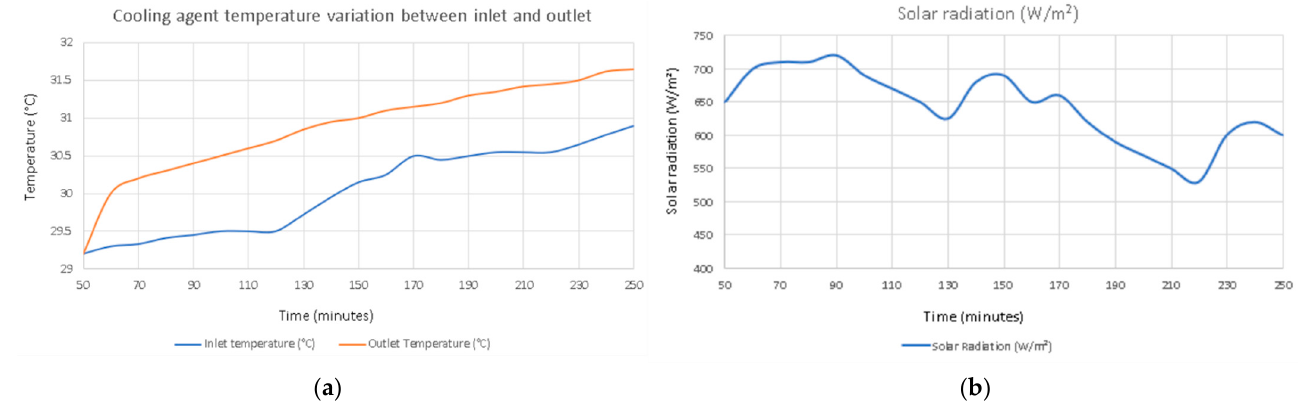
Figure 3. ( a ) Sample coolant temperatures monitored during a test; ( b ) monitoring solar radiation using a